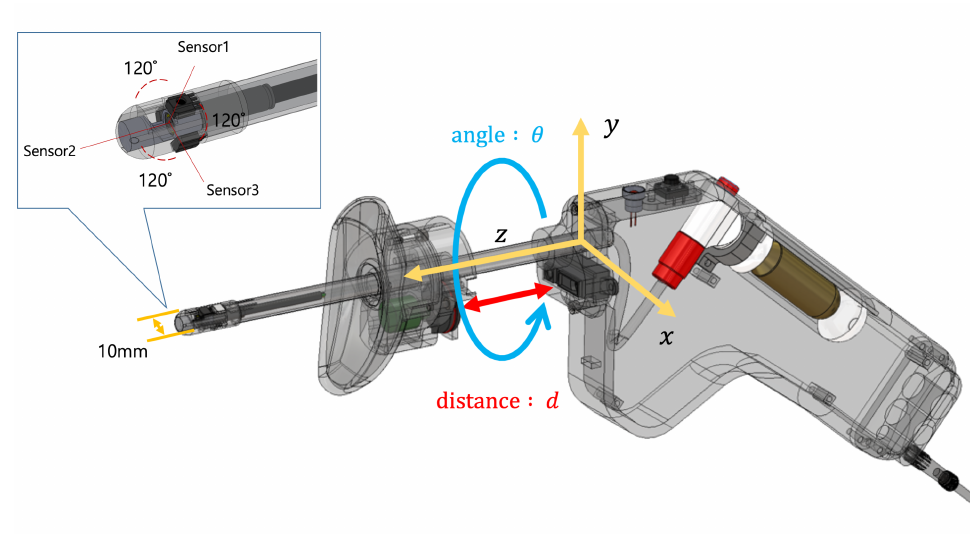
Figure 2. Consideration of requirements to recognize the exact location and condition through the vaginal endoscope and description of the experimental system to measure the position, orientation, and the